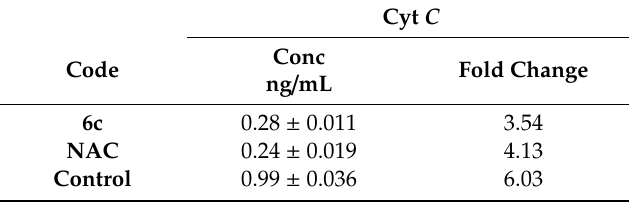
Table 4. E ff ects of compound 6c and NAC on cytochrome C in SR human cell line.